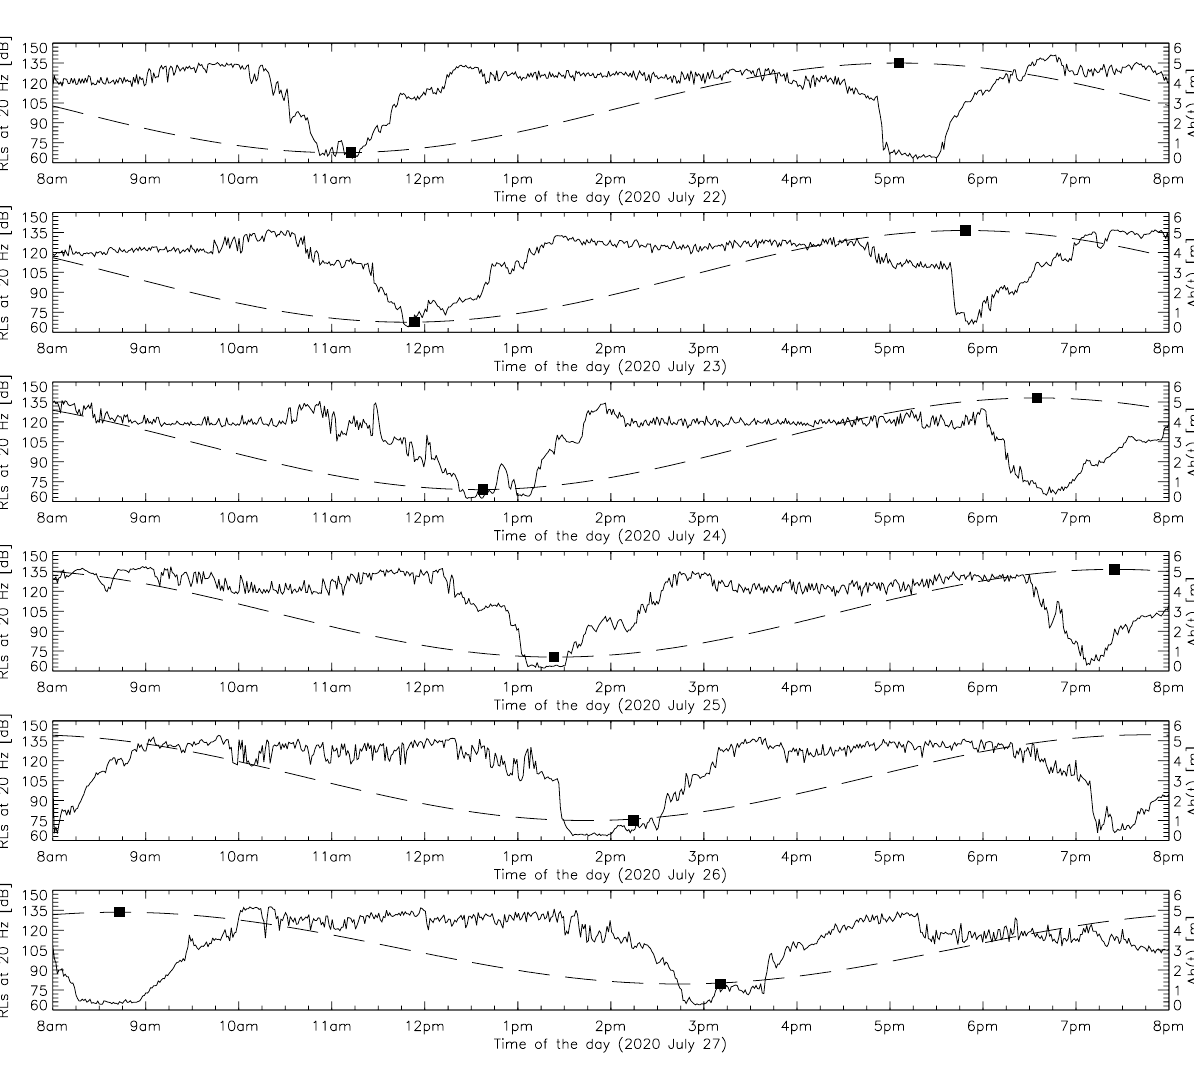
Figure 8. Time series of the RLs measurements at 20 Hz retrieved from the Kamouraska quiet coastal island (see Fig. 1). The recording setup and data processing methods are identical to the description in “Acoustic data” section. Curves of received noise levels are shown for full 12-h periods of continuous recording. No AIS-listed ships were present. Filled squares indicate the local EDT time of the day for low and high tides (see right-hand ordinate). Sinusoidal fits of the ebb and flood tides are shown as long-dashed